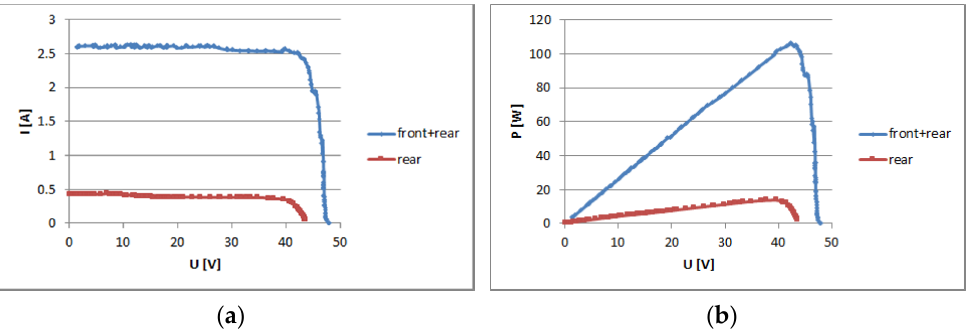
Figure 12. The whole vs. rear side yield characteristics benchmark in a bifacial module: ( a ) current- voltage characteristics; ( b ) power-voltage characteristics for 75 ◦ inclination, over the grass substrates. Table 11. The measurement results and calculations for 75 ◦ inclination of the module over the grass substrate, considering the values for the whole-module generation and its rear side generation.